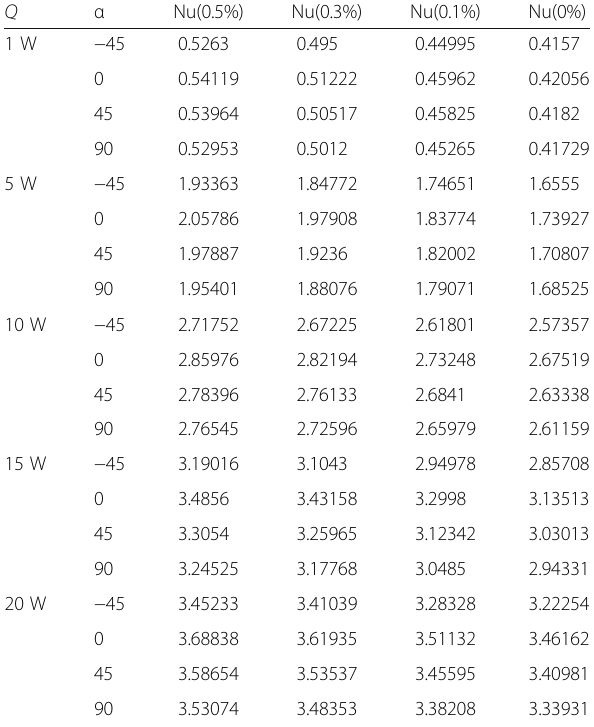
Table 4 Nusselt numbers ( A = 1:4). Nusselt number values based on Fig. 14 ( A =